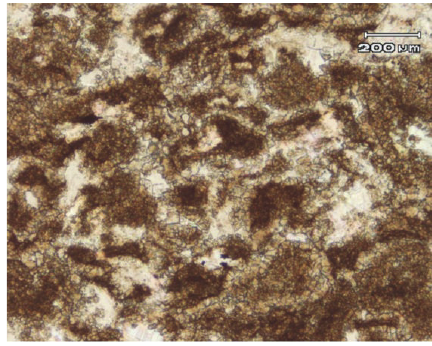
Figure 6: Dolomicrite: bird’s-eyes were filled with calcite or gyp- sum, S1, 3571.8 ∼ 3572.1 m, T 1 j 2 .